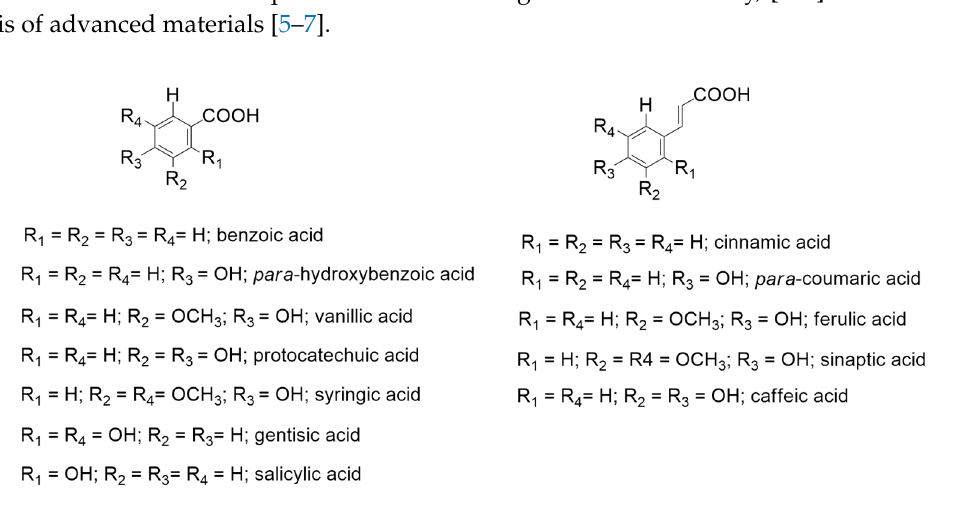
Figure 1. Phenolic acids: Examples of hydroxybenzoic and hydroxycinnamic acids.